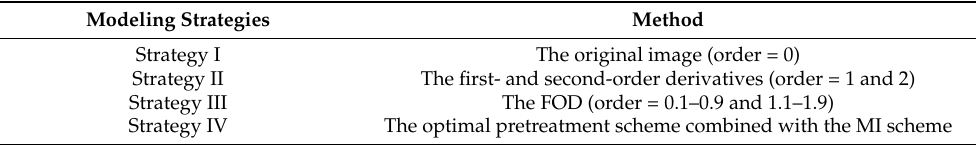
Table 4. Modeling strategy and description. Table. 4. Modeling strategy and description.